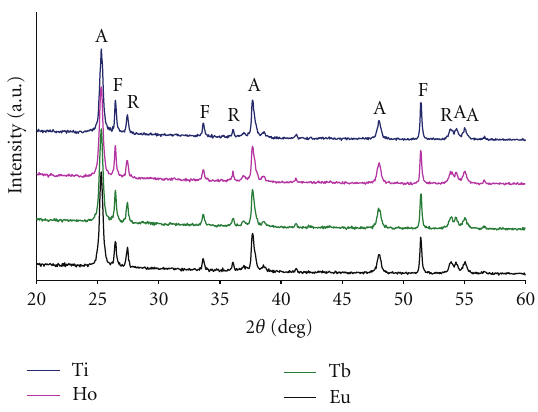
Figure 1: XRD patterns of selected electrodes. Reflexes are indicated as follows: A–anatase, R–rutile and F–FTO substrate.